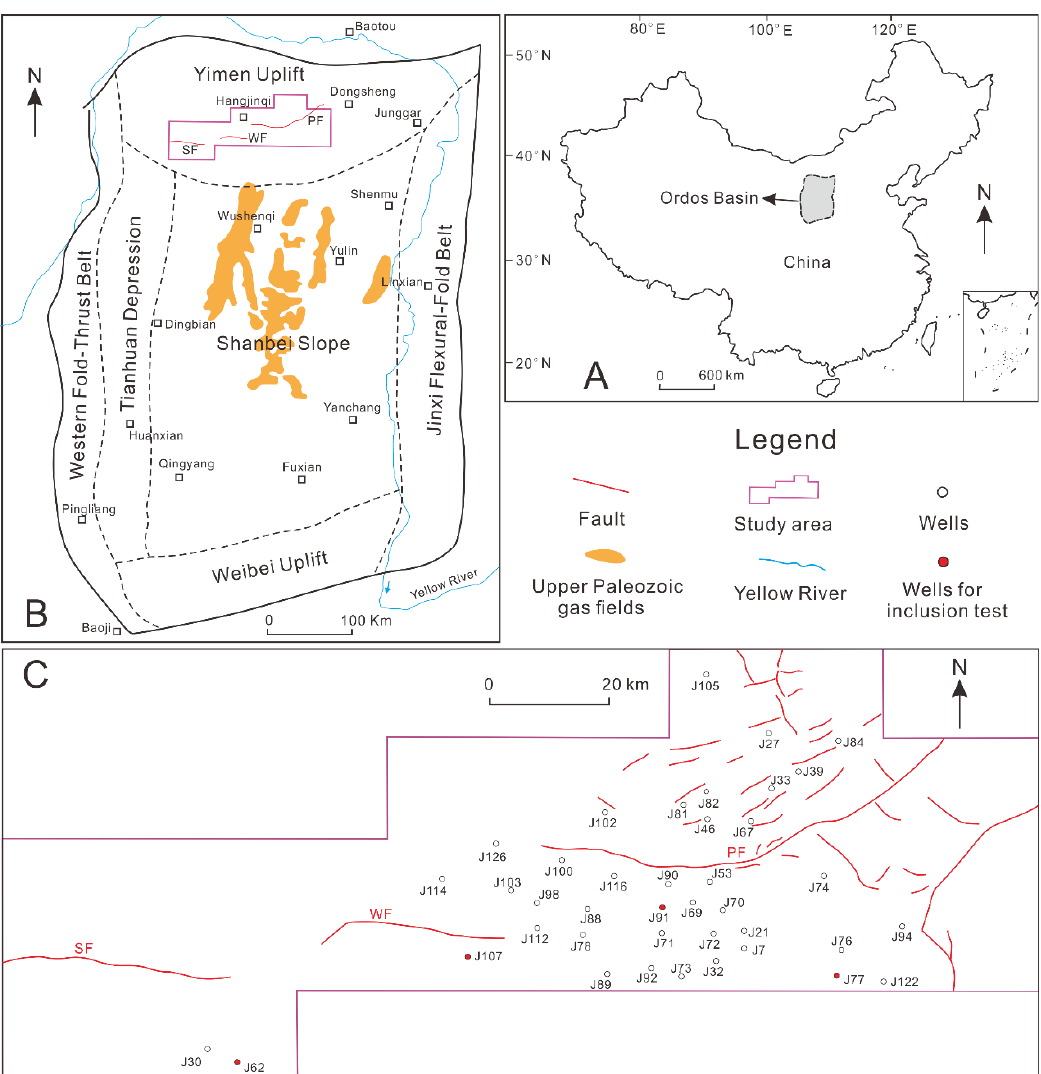
Figure 1. ( A ) Location map of the Ordos Basin in China; ( B ) Tectonic units and Upper Paleozoic gas fields in the Ordos Basin. Modified from Yang et al. (2015) [24]; ( C ) Drilling wells and main faults in the Hangjinqi area. PF: Porjiang-haizi fault; WF: Wulan-jilinmiao fault; SF: Sanyanjing fault.